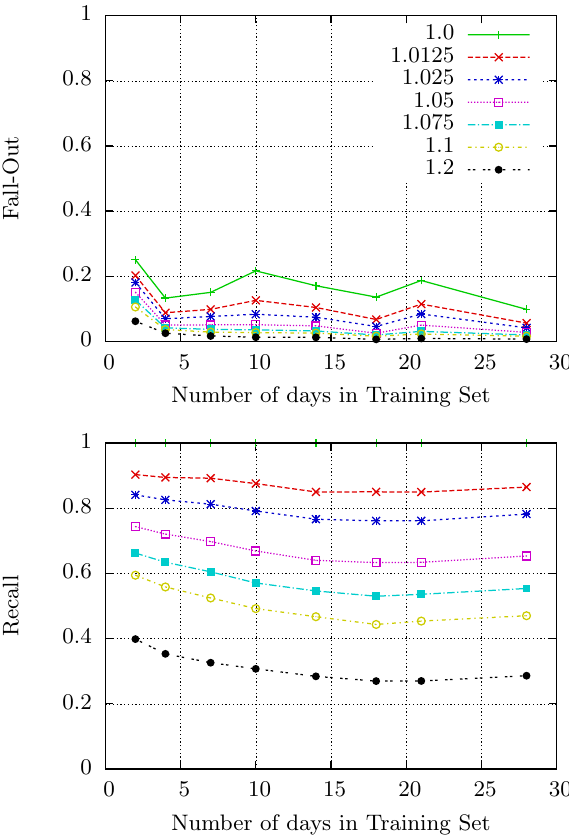
Figure 3: ClusterDist-based decision over number of days in training set and varying threshold T